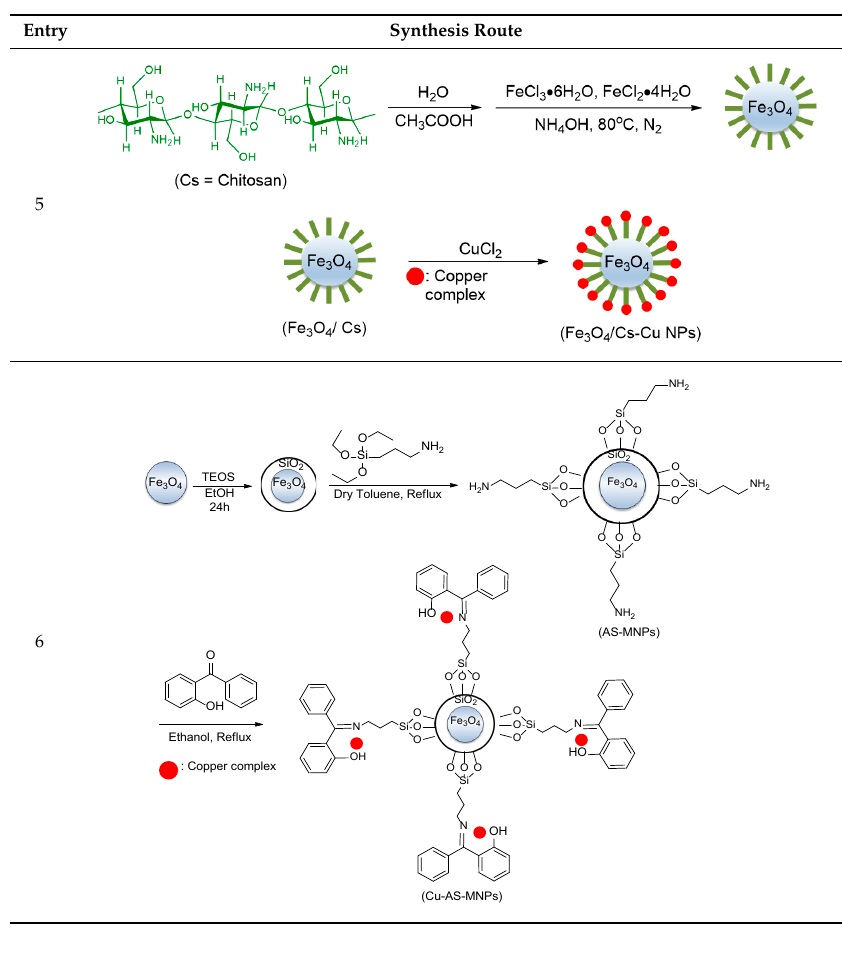
Table 3. The various type of Maghemite-supported Copper nanoparticles catalyzed synthesis of biphenyl ethers.